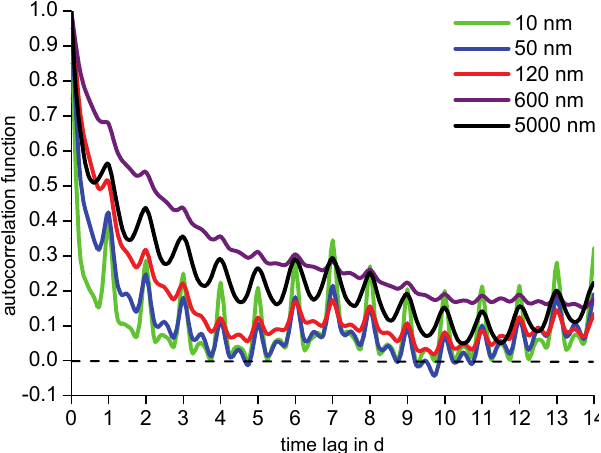
Fig. 6. Auto-correlation function of particle number concentration at selected particle